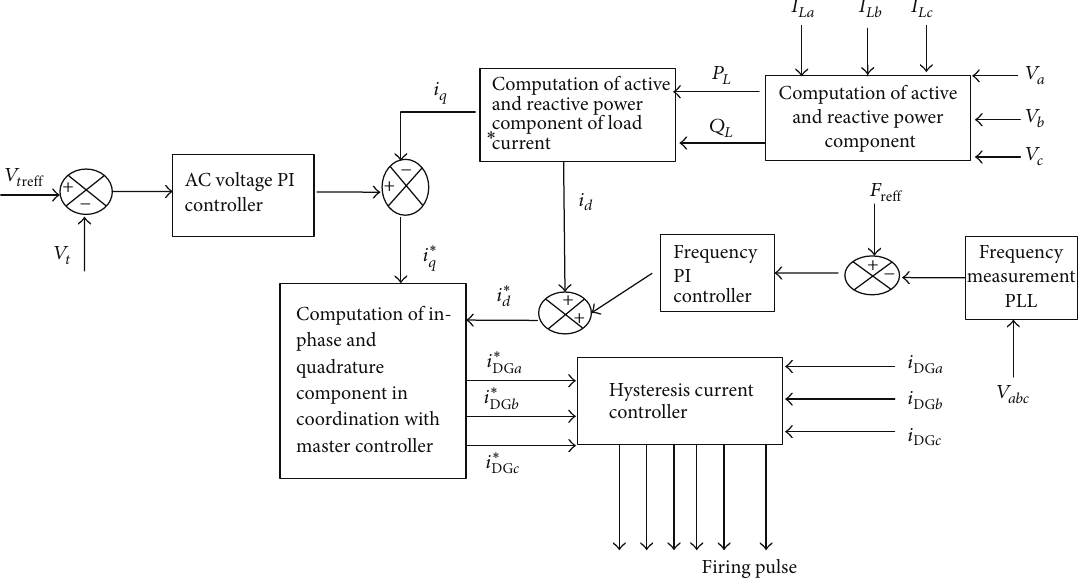
Figure 6: Control scheme for single slave controller in